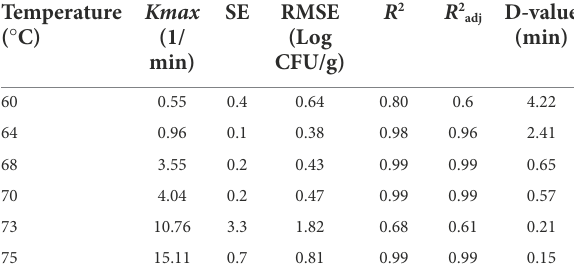
kmax, specific inactivation rate; SE, standard error; RSME, root mean squared errors; R 2 , regression coefficient; R 2 adj , adjusted coefficient of determination (as given in GInaFit); D-value: decimal reduction time.